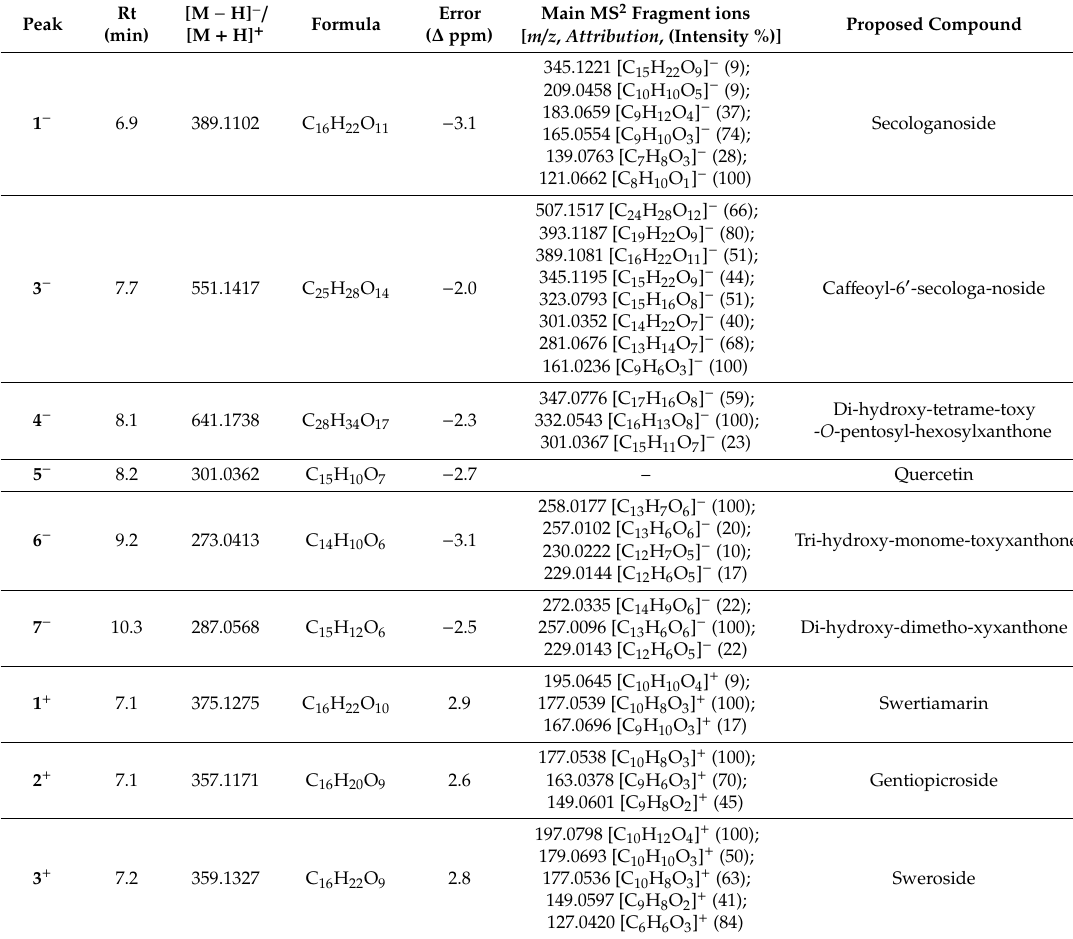
Table 1. Identification proposal of the compounds present in the complete decoction by LC–MS / MS in ESI negative and positive mode. Peaks with a minus / plus superscript were analyzed in negative / positive mode. Compounds are indicated by retention time (Rt) order and numbered according to the appearance in each chromatogram, negative [M − H] − or positive mode [M + H] + .